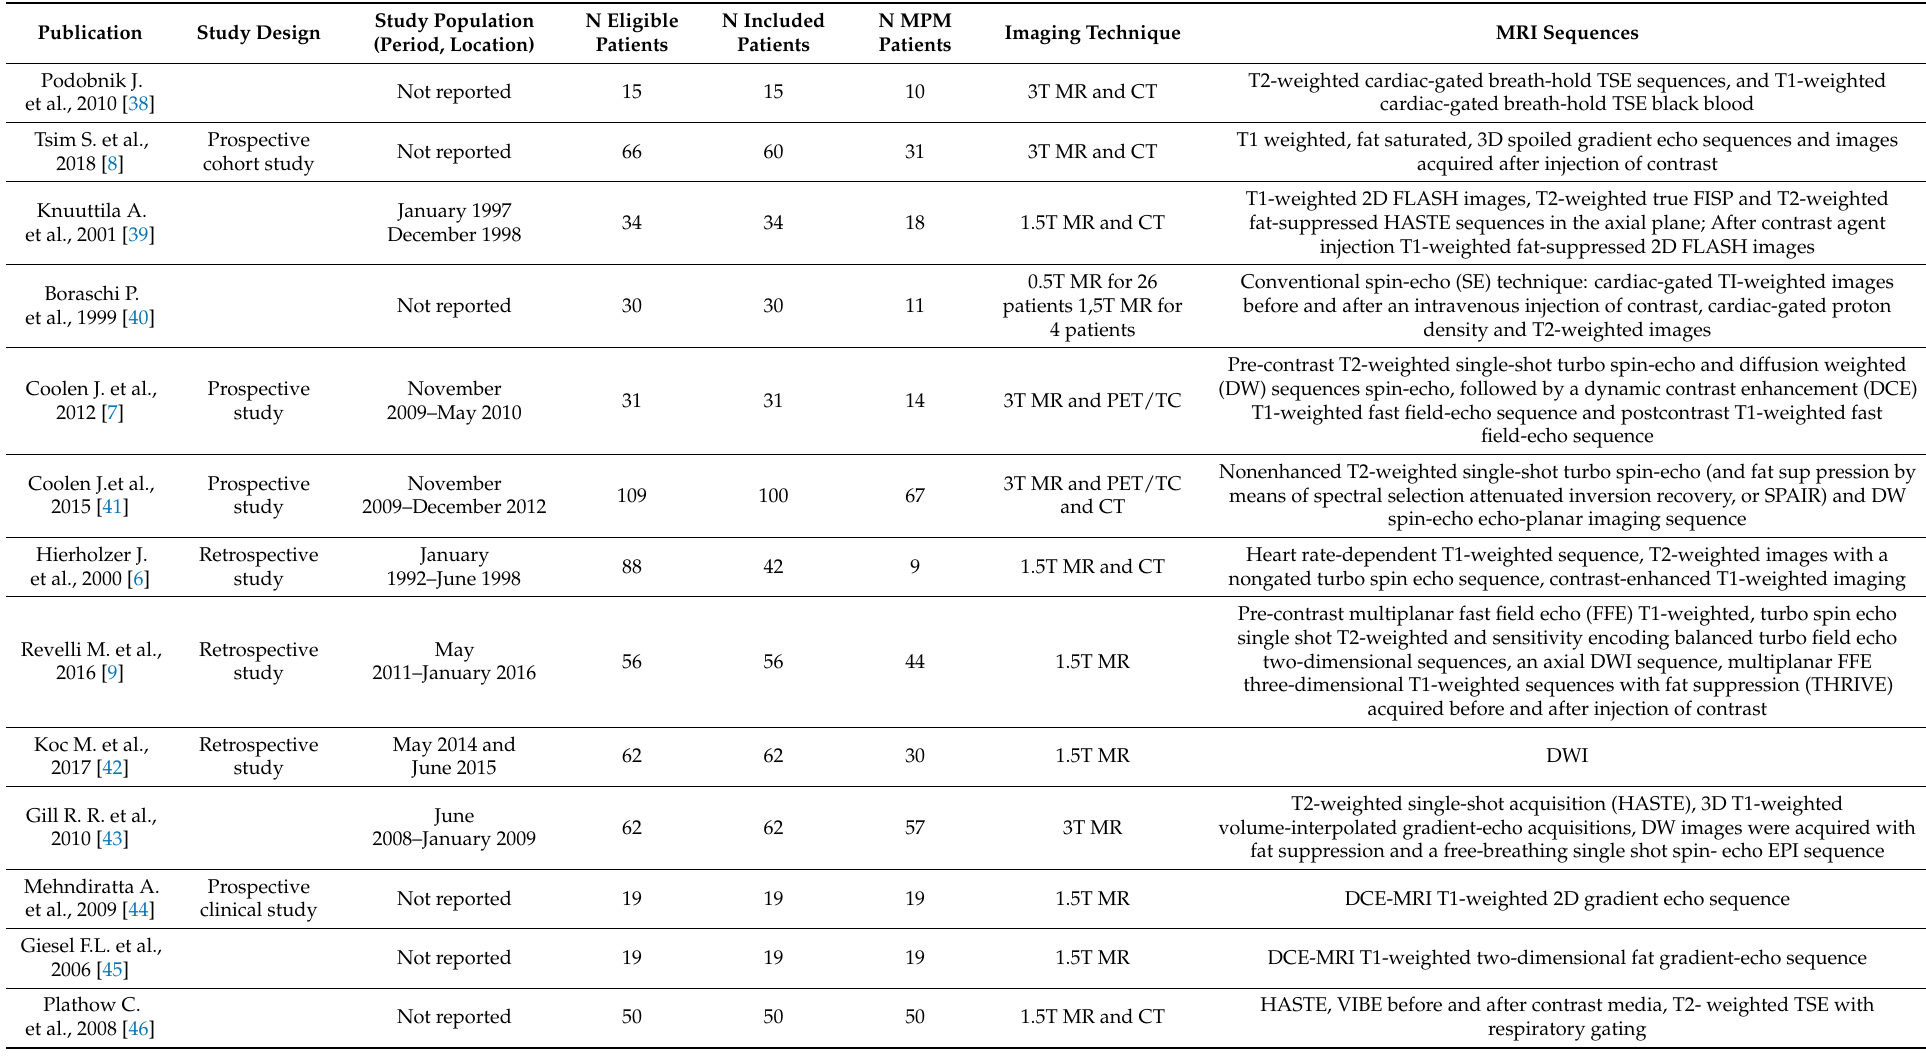
Table 2. Summary of magnetic resonance studies included in the